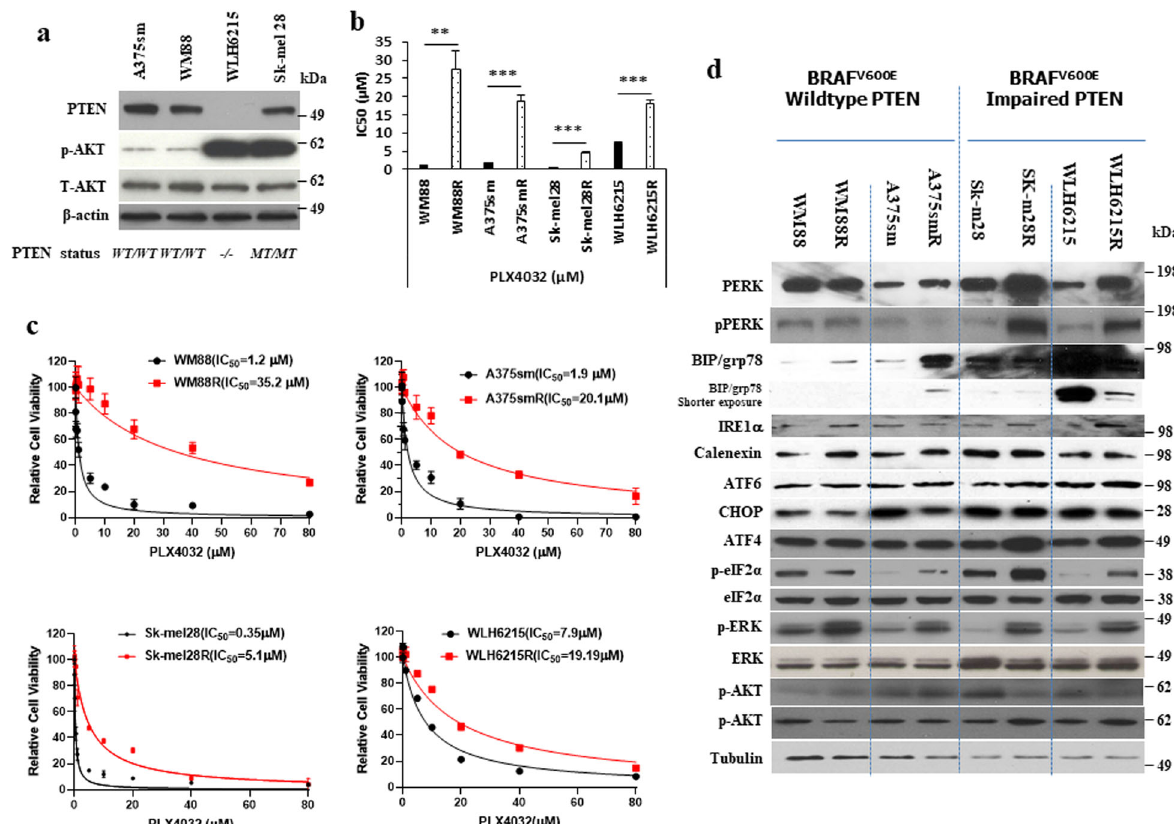
Fig. 1 PERK was upregulated in BRAFi-resistant human melanoma cells with impaired PTEN. a The western blotting showed the protein level of PTEN, pAKT, and AKT in BRAF V600E human melanoma cell lines with various PTEN genetic backgrounds. The protein level of β -actin is the loading control. b The values of 50%-inhibitory concentration (IC50) of 4 pairs of parental and resistant human melanoma cells were determined using CCK8 assays. Error bars denote s.d. for biological three repeats. Results are statistically signi fi cant between parental and resistant groups by Student ’ s t -test (* p < 0.05, ** p < 0.01, *** p < 0.001). c The cell viability curves of 4 pairs of parental (WM88, A375sm, Sk- mel28, and WLH6215) and resistant (WM88R, A375smR, Sk-mel28R, and WLH6215R) human melanoma cells were determined using CCK8 assays. Error bars denote s.d. for biological three repeats. d The western blotting showed the indicated protein level in BRAF inhibitor-resistant melanoma cell lines with various PTEN genetic backgrounds, the protein level of tubulin as the loading